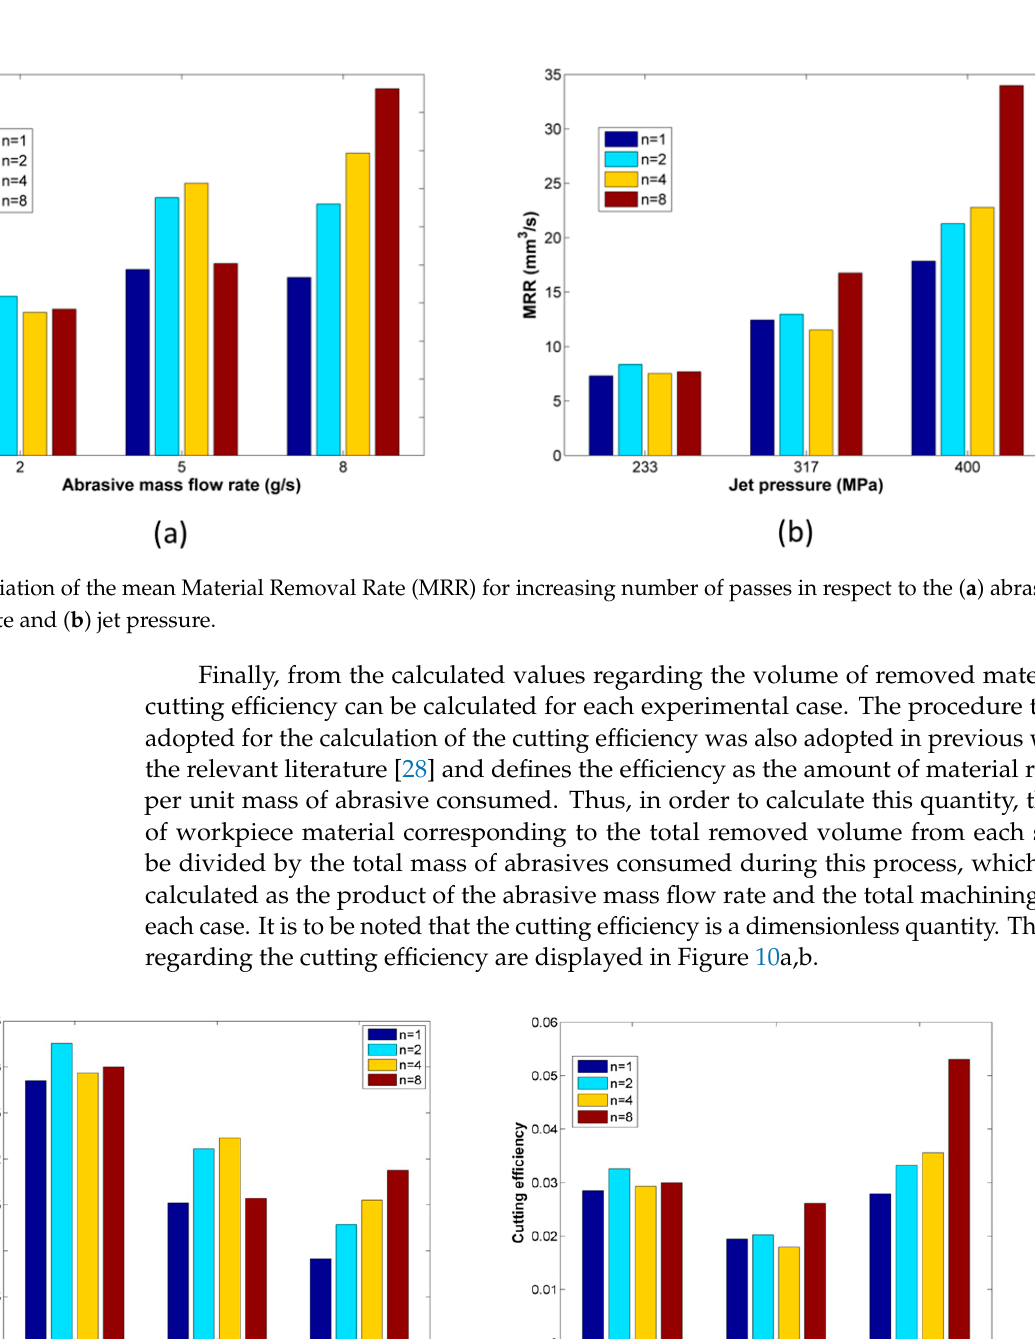
Figure 9. Variation of the mean Material Removal Rate (MRR) for increasing number of passes in respect to the ( a ) abrasive mass flow rate and ( b ) jet pressure.